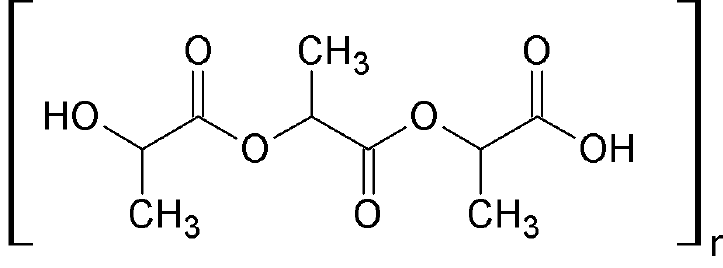
Figure 25. Structure of poly ( L -lactic acid) (PLA) pristine bionanomolecules.